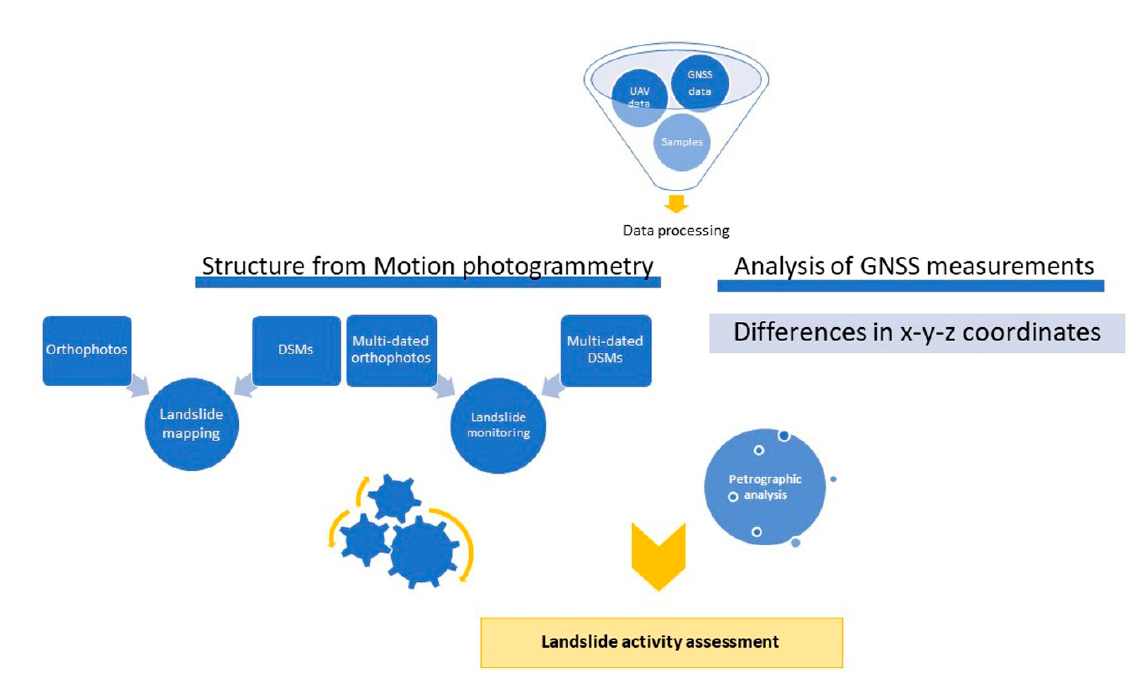
Figure 5. Flowchart representing the applied methodology.